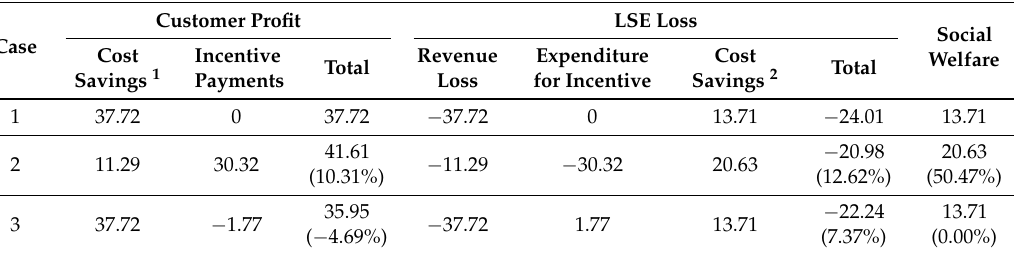
Table 3. Total profit and loss on Day 2 (unit: $).